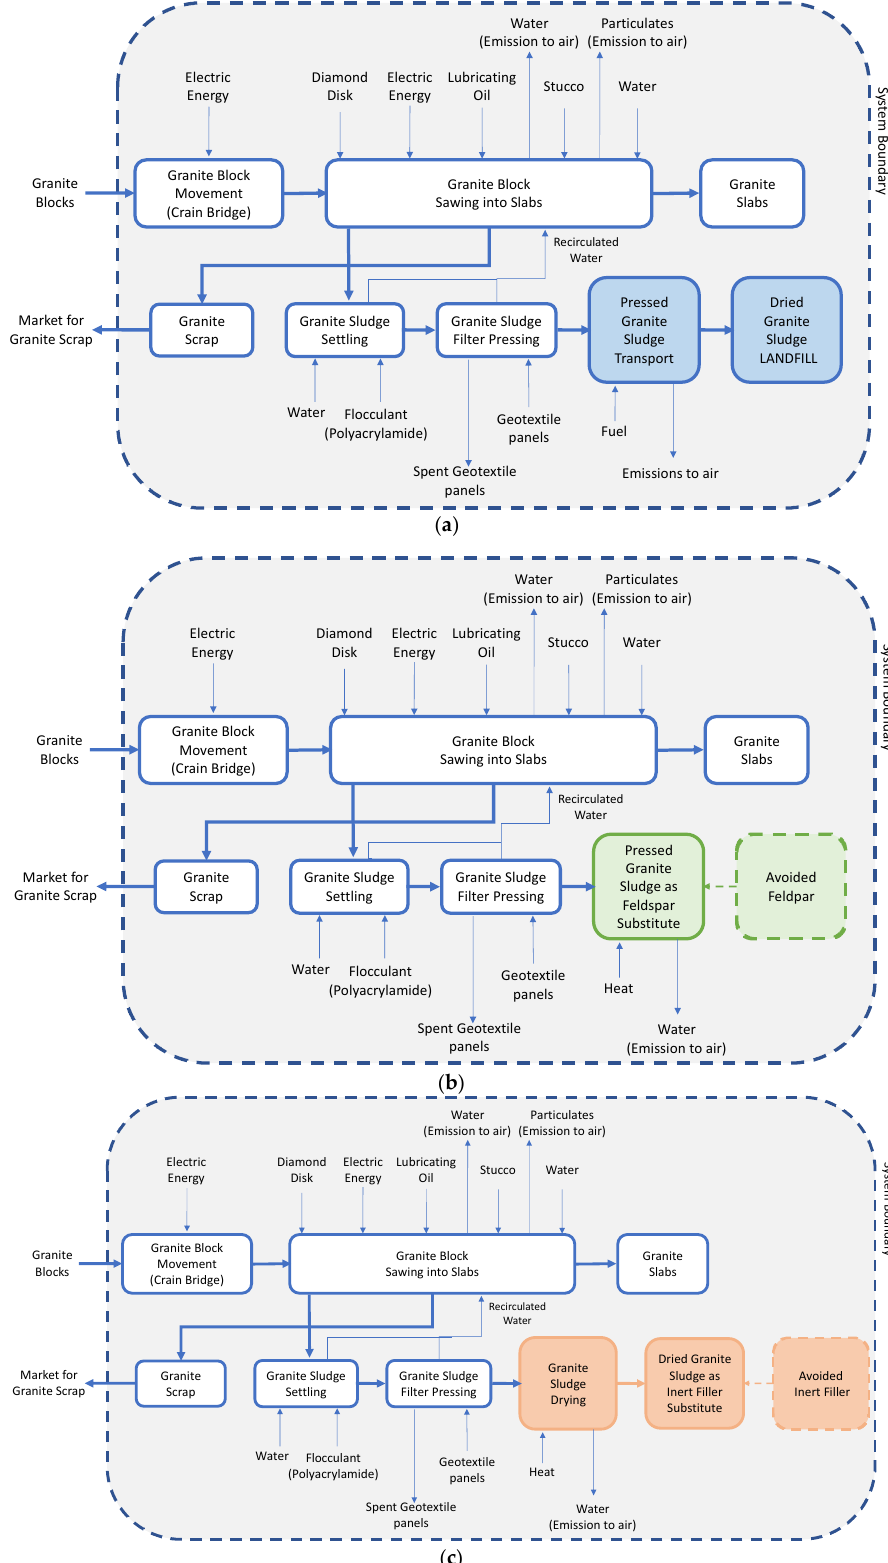
Figure 1. Model diagrams of the granite block sawing process considering ( a ) GS landfill disposal (Scenario 1), ( b ) GS valorisation as a substitute for feldspar in the ceramic industry (Scenario 2), and ( c ) GS valorisation as a substitute for inert filler in concrete production (Scenario 3). The blue dashed line represents the system boundaries.